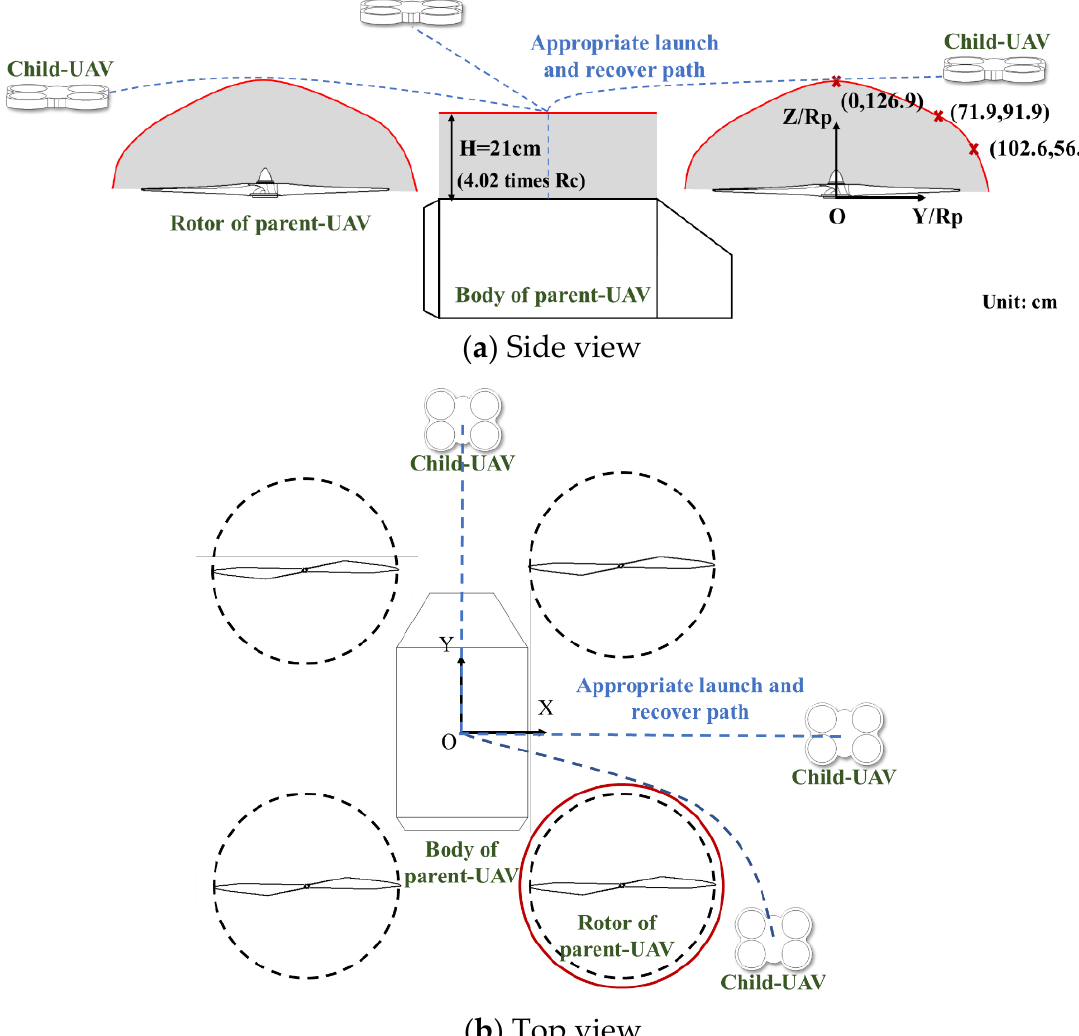
Figure 24. The safe flight boundary and appropriate path of children-UAVs.